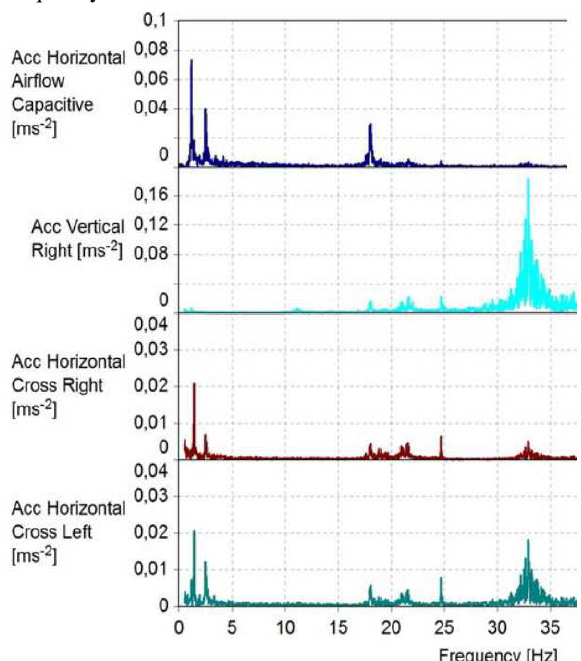
Fig. 18. Frequency spectra of acceleration measured on the glass